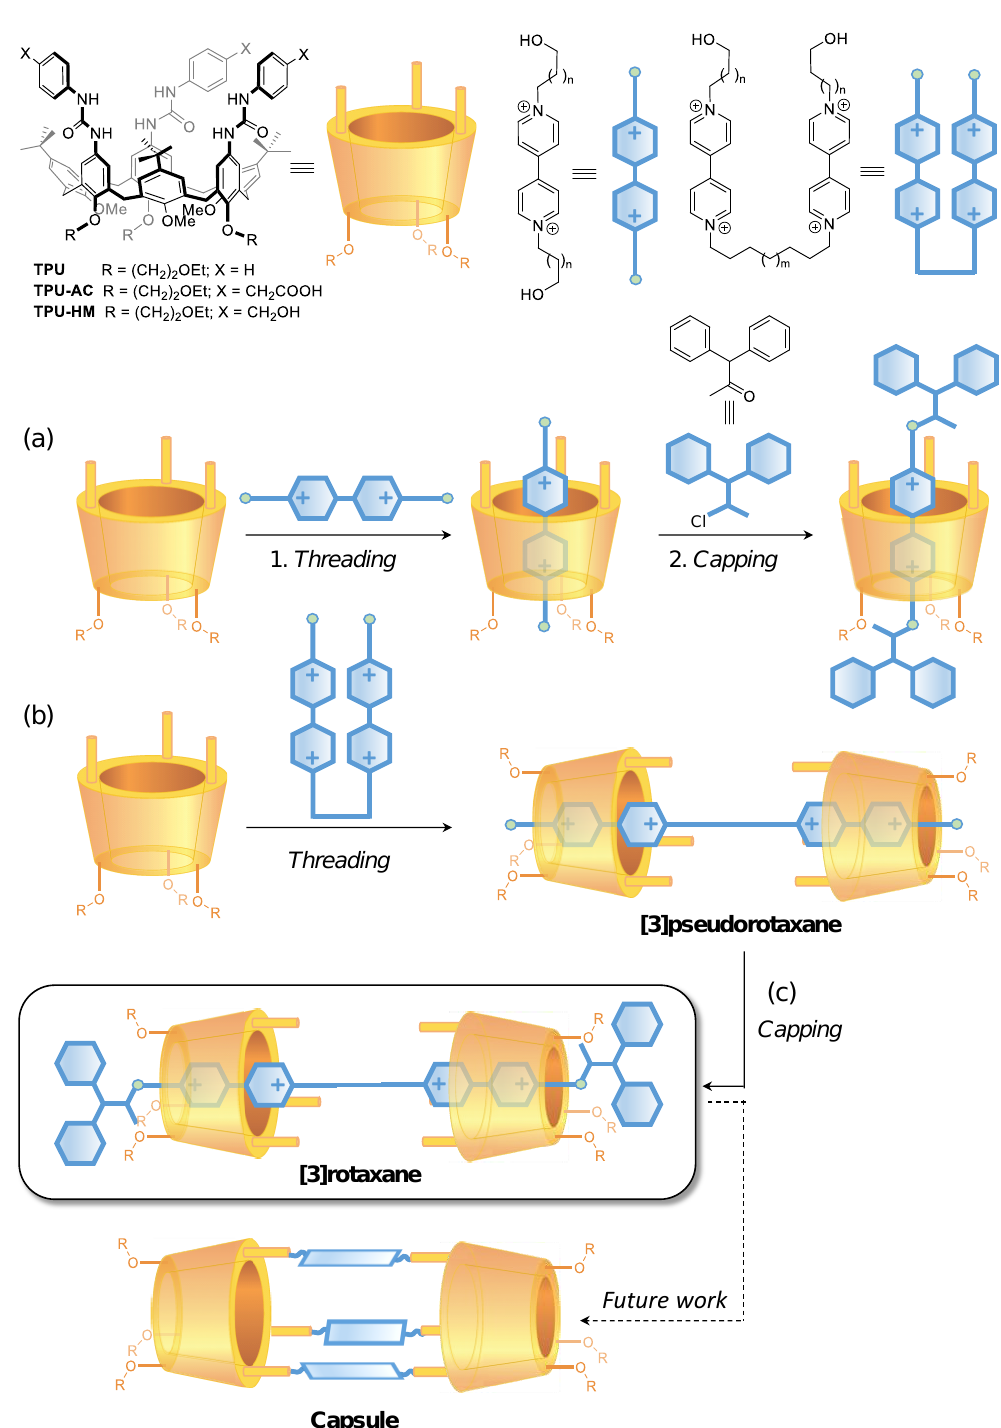
Figure 1. Schematic representation of calix[6]arene-based ( a ) [2]rotaxanes, ( b ) oriented upper-to- upper [3]pseudorotaxanes, and ( c ) [3]rotaxanes as prototypes for the synthesis of molecular cap- sules.